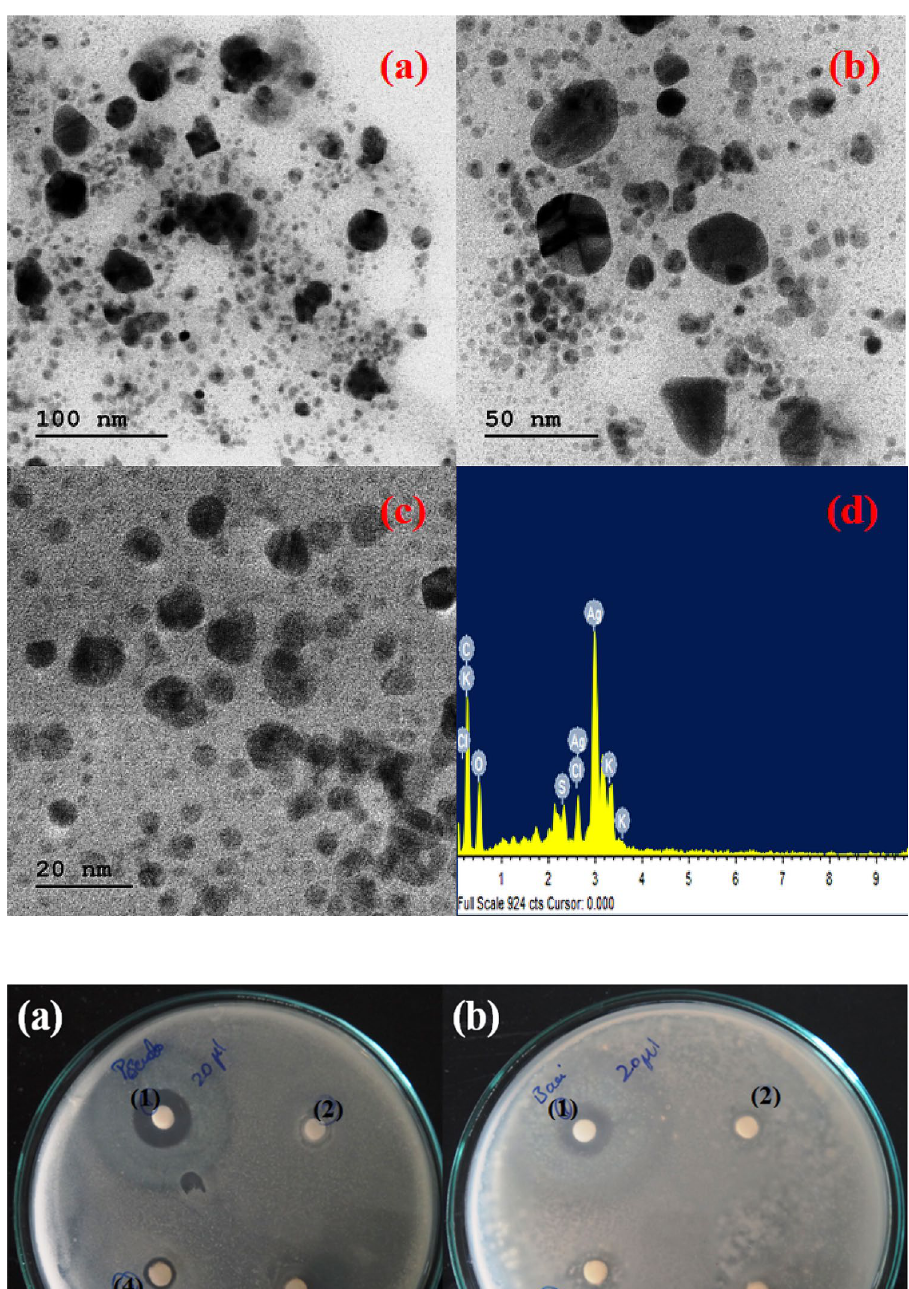
Fig. 5 TEM and EDAX images of AgNPs prepared by using the M. wightii leaf extract